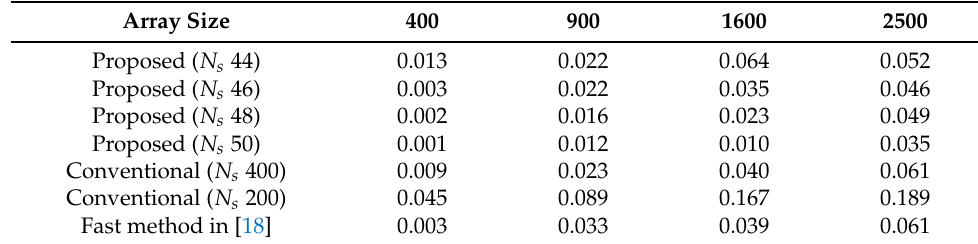
Table 1. Comparison of sidelobe absolute errors (dB) with different methods.